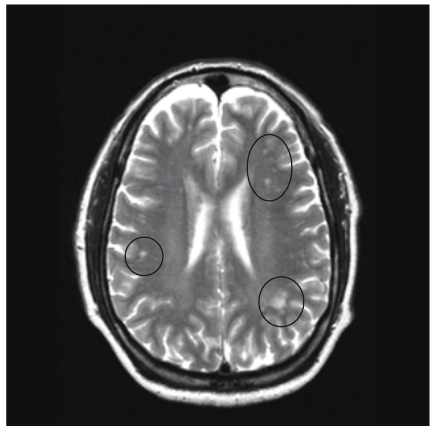
Figure 1: MRI image of the brain in an axial view showing the “precontrast FLAIR image”. Note the abnormal lesions (circled) in the per ventricular area suggesting white matter pathology.